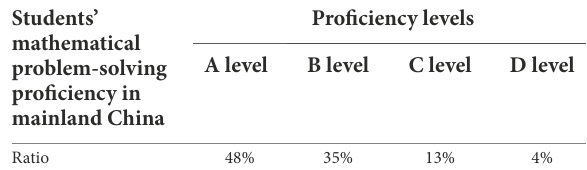
TABLE 1 The ratio of different proficiency levels of students’ mathematical problem-solving